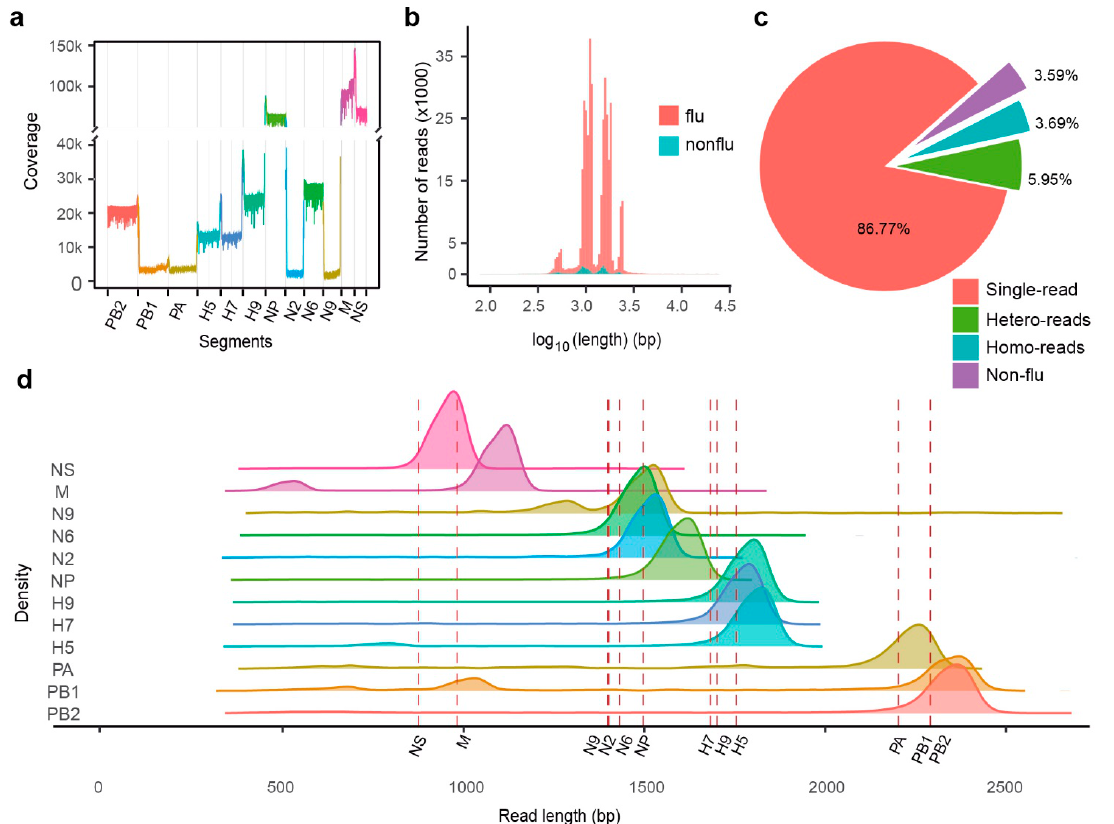
Figure 3. Statistics of cDNA sequencing reads of MinION platform for influenza A virus sample. ( a ) Coverage of cDNA sequencing reads of MinION platform to Illumina consensus sequences. ( b ) Length distribution of raw reads, the flu reads (red) and the non-flu reads (blue). ( c ) Proportion of different types of reads in raw data. Single-read was a raw read containing only one segment. Hetero-reads were reads consisting of two different segments. Homo-reads were reads consisting of two same segments. Nonflu reads were not flu virus reads. ( d ) Density plots for length of separated segments. The red dashed lines depicted the length of each related segments, respectively.